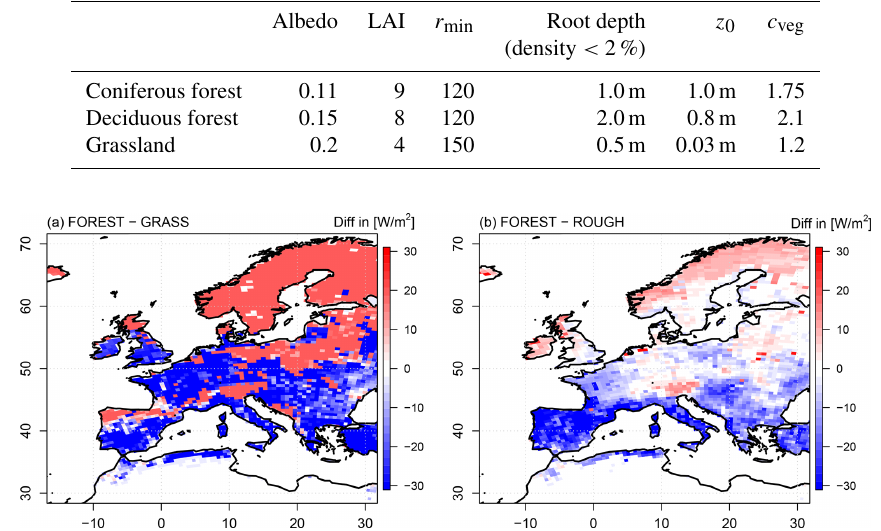
Figure 2. Differences in mean seasonal latent heat fluxes in summer between the FOREST and the GRASS experiments (a) and the FOREST and the ROUGH experiments (b) over the simulation period